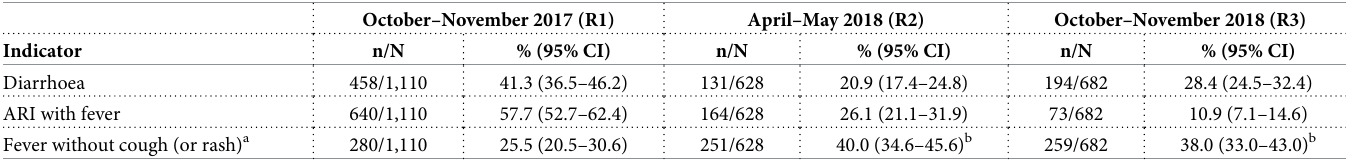
Table 3. Two-week prevalence of caregiver-reported morbidity among Rohingya children 6–59 months of age in makeshift and informal settlements—Bangladesh,